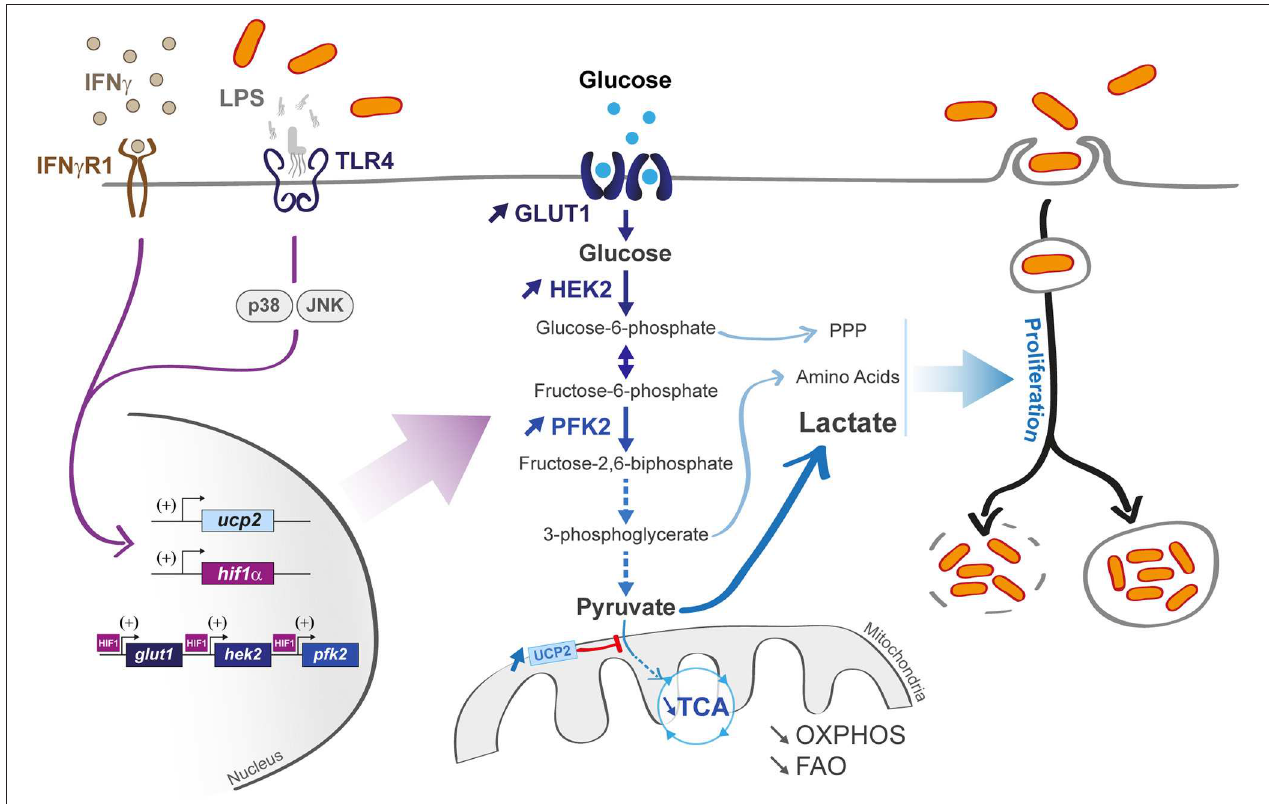
FIGURE 2 | Macrophage infection affects host metabolic state and can induce an M1 profile. M1 macrophages are characterized by a hyper-activated glycolysis coupled with a limited mitochondrial activity (limited OXPHOS and FAO) upon lipopolysaccharide (LPS) or interferon gamma (IFN γ ) activation (left part). The transporter Glut 1 and the glycolytic enzymes hexokinase 2 (HEK2) and phosphofrucotkinase 2 (PFK2) are activated (central part) in a hypoxia-inducible factor 1- α (HIF-1 α )-dependent manner. LPS also activates the uncoupling protein 2 (ucp2) transcription via p38 and JNK pathways, leading to a decrease in pyruvate incorporation into TCA cycle. Some pathogens (vacuolar or cytosolic, right part) can use glycolytic derivatives [such as pentose phosphate pathway (PPP) metabolites, amino acids, and lactate] as nutrients to sustain their propagation.